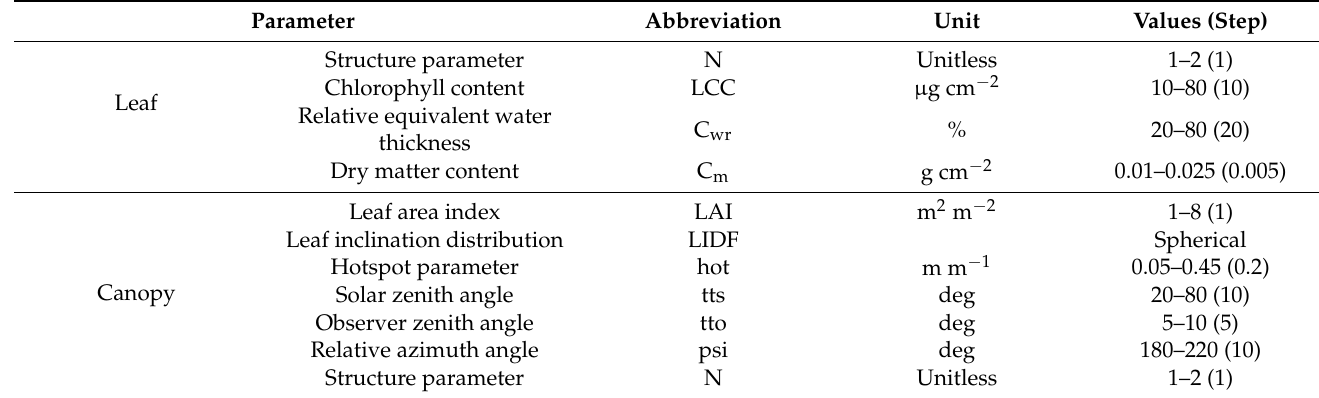
Table 3. Ranges of input parameters for the PROSAIL model for the generation of the